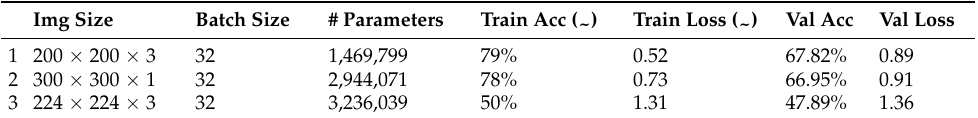
Table 2. Model A training and validation results.